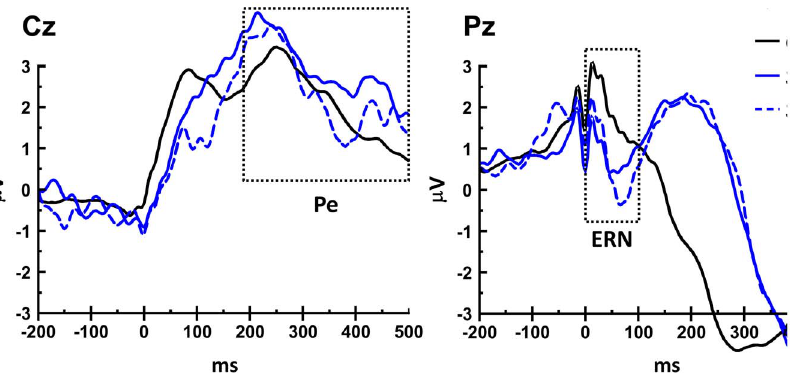
Figure 4. ERP curves during stop and go trials at Cz and Pz channels, time-locked to button press (at 0 ms). The peak-to-peak analysis showed that ERN occurred in both SEi and SEni trials at Pz, compared to G trials. Furthermore, signed-rank test showed that ERN was greater in SEni than SEi trials at Pz. On the other hand, the peak-to-peak analysis showed that Pe occurred in both SEi (at Cz and Pz) and SEni (at Pz), compared to G trials. Furthermore, signed-rank test showed that Pe was greater in SEi than SEni at Cz. These results showed that the amplitude of Pe, not ERN, increased in stop error trials immediately preceding go trials with RT slowing.